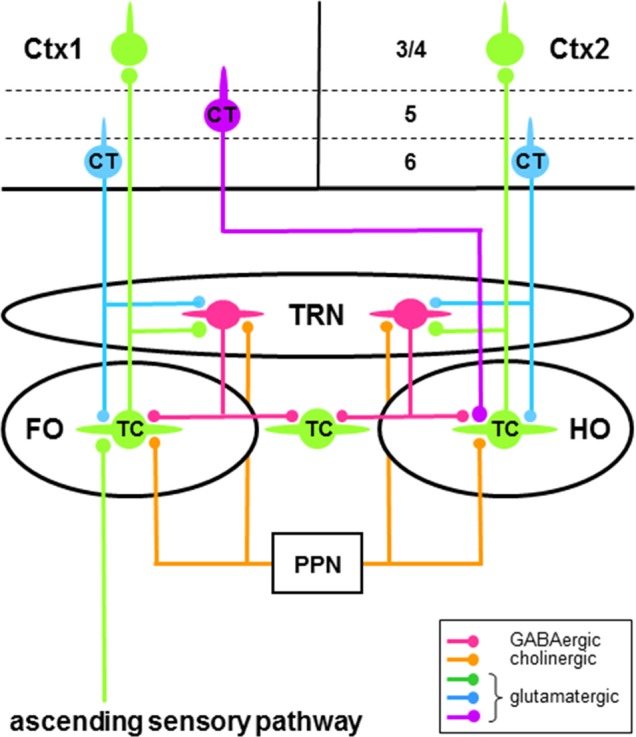
Schema of some neural circuitry of the thalamus, cortex and brainstem. Circuits showing first order (FO) and higher order (HO) connections of thalamocortical (TC) neurons (green cells) with neurons of the thalamic reticular nucleus (TRN; red cells) and cortical areas 1 (Ctx1) and 2 (Ctx2). Only the major thalamic-related input (layer 3/4) and output (layers 5 and 6) cortical laminae are shown. First order TC neurons receive driver afferents through ascending sensory pathways (green), whereas higher order TC neurons receive driver afferents through descending pathways (purple) from corticothalamic (CT) neurons in layer 5 (purple cell). Ascending and descending driver afferents have large axon terminals, whereas descending modulator afferents to TC and TRN neurons from CT neurons in layer 6 (blue cells) have small axon terminals. Note that TRN neurons can engage in closed-loop and/or open-loop circuits with TC neurons. Only brainstem modulator inputs (orange) from the pedunculopontine nucleus (PPN) are shown.